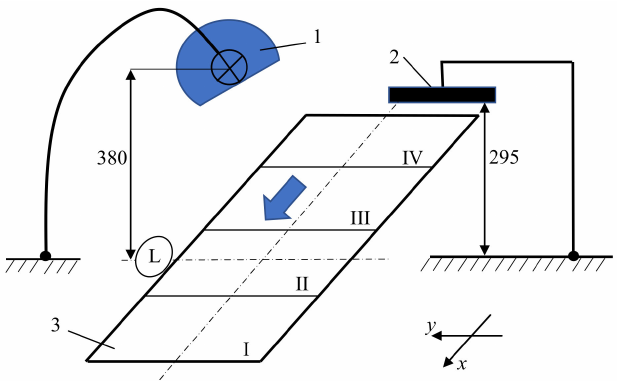
Figure 1. The scheme of obtaining images in areas of the metal strip (I–IV) with damage: 1—lamp; 2—camera; 3—metal strip with damage; L is a light meter.